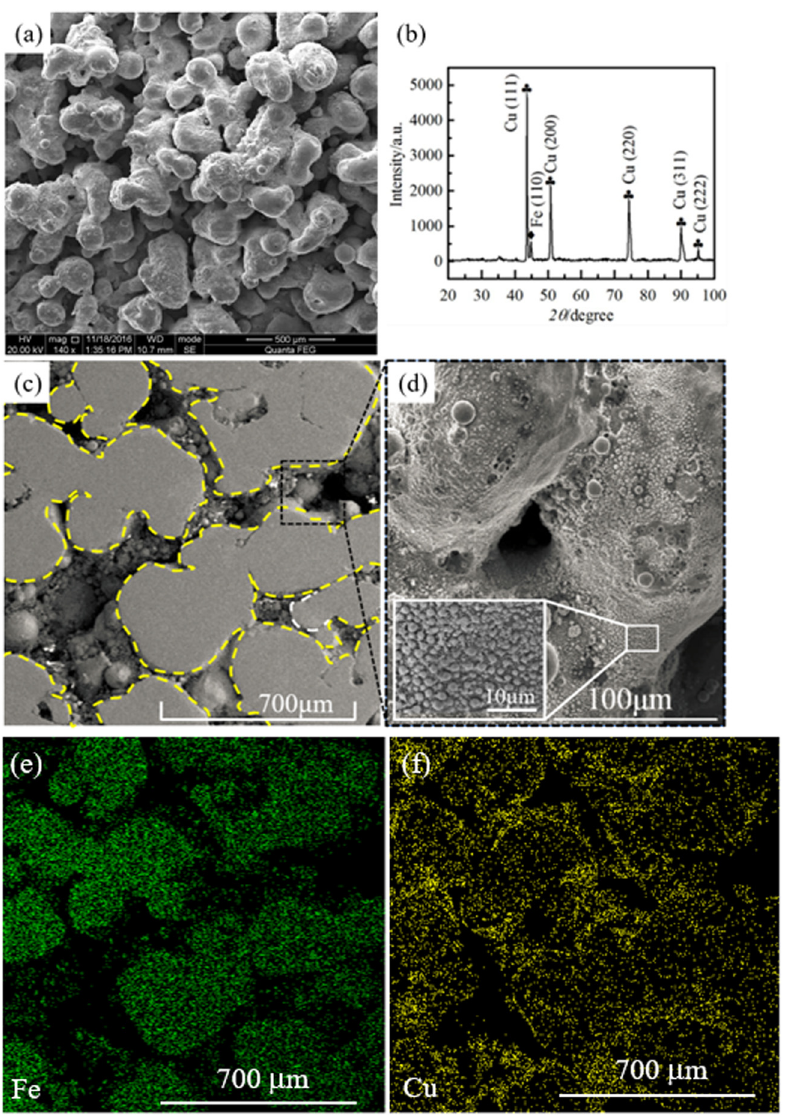
Figure 2: ( a ) Surface morphology of the HMS sample investigated using an SEM; ( b ) XRD results of the HMS sample. ( c and d ) SEM images showing the surface morphology of the sintered HMS sample with a unique micro/nano hierarchical structure. ( e and f ) Energy - dispersive spectroscopy elemental mapping of the as - sintered HMS sample for Fe and Cu